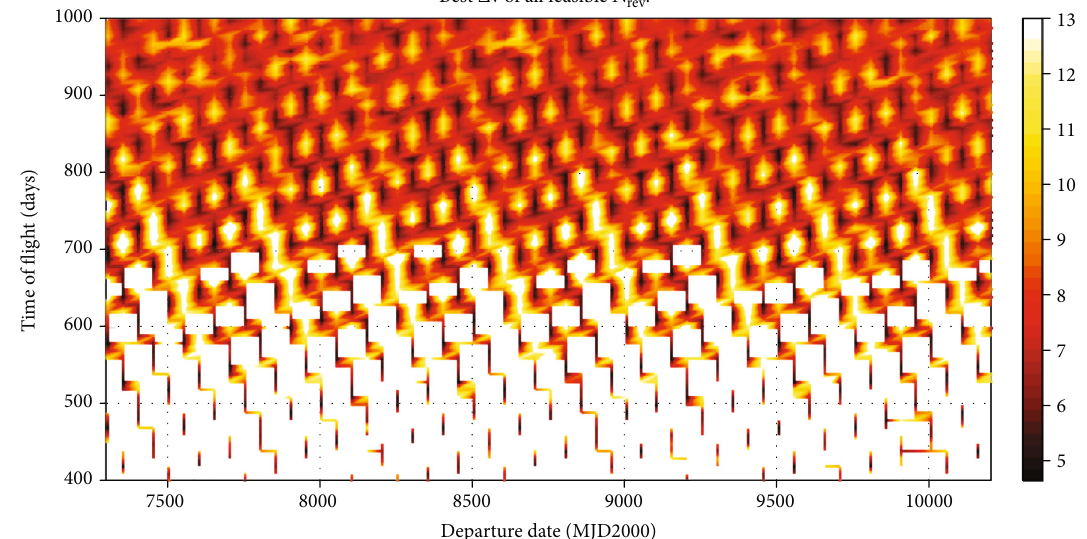
Figure 7: Launch window analysis of the Earth to asteroid 1989ML mission.